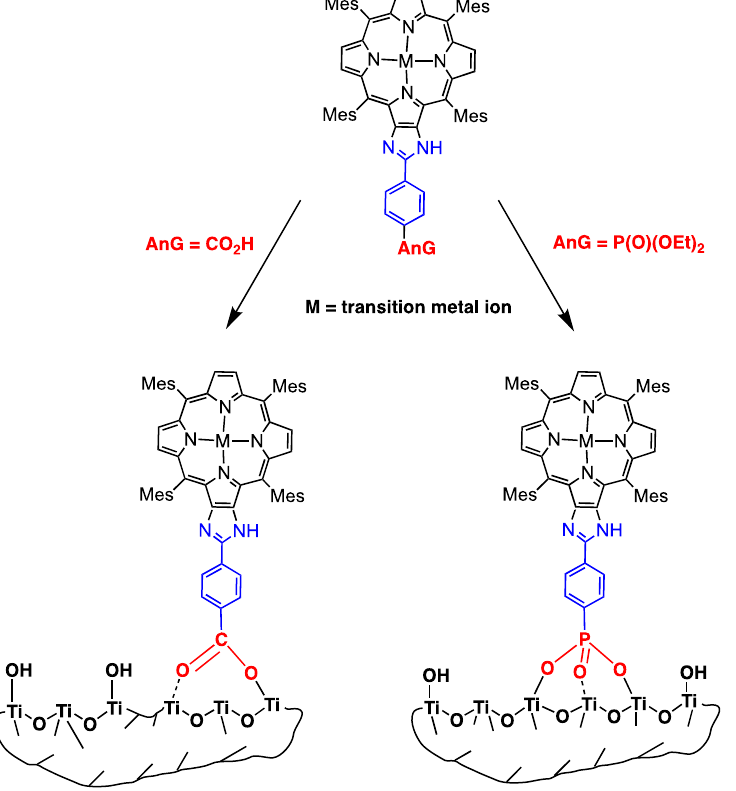
Figure 1. Strategies for the immobilization of porphyrin catalysts on hydrated titania supports, which were investigated in this work.